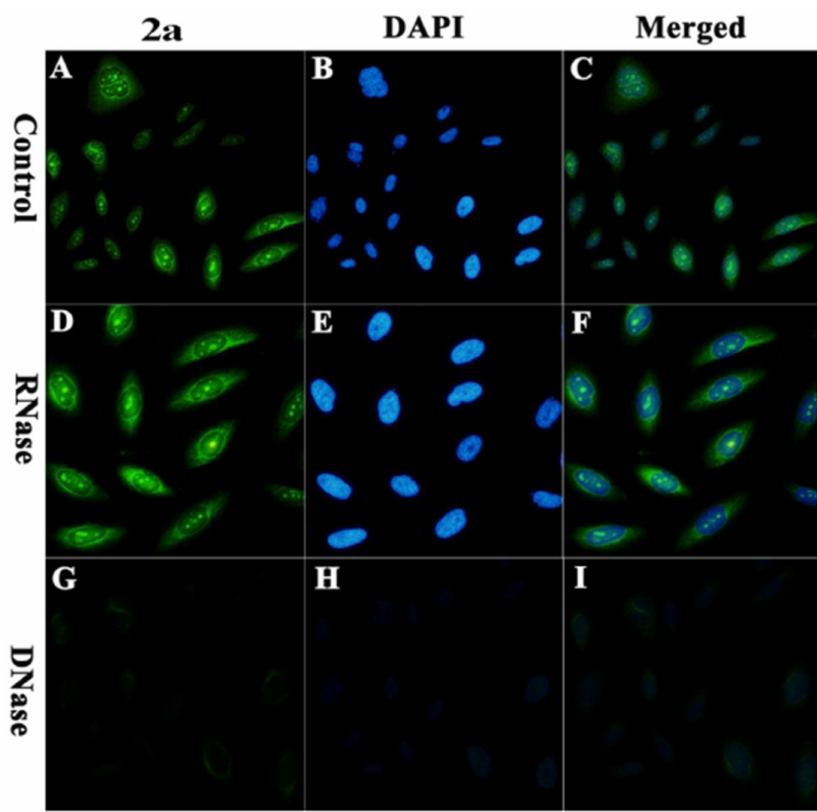
Figure 4. Fluorescence microscopy of live PC3 cells stained with pyridinium derivative and DAPI. The fluorescent foci corresponding to probe observed in merged image is speculated to be rDNA rich nucleoli which is G rich and has potential to fold into G4 structures. (adapted with permission from